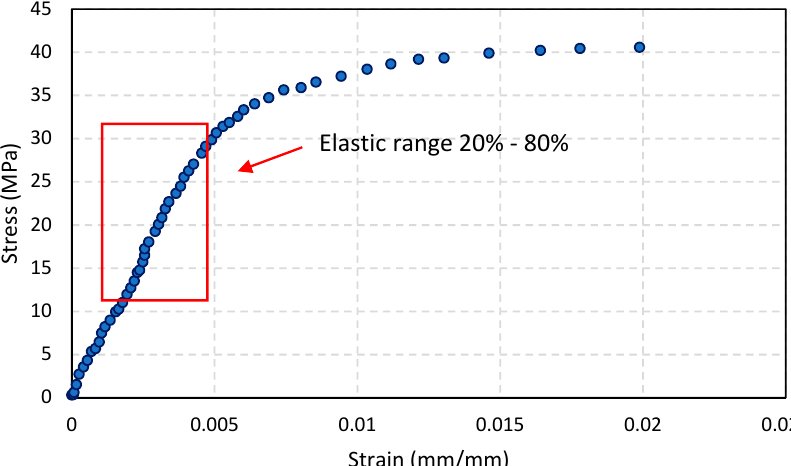
Figure 8. Area in which the modulus of elasticity in compression parallel to the grain (MOE c ) is determined for specimen A1.